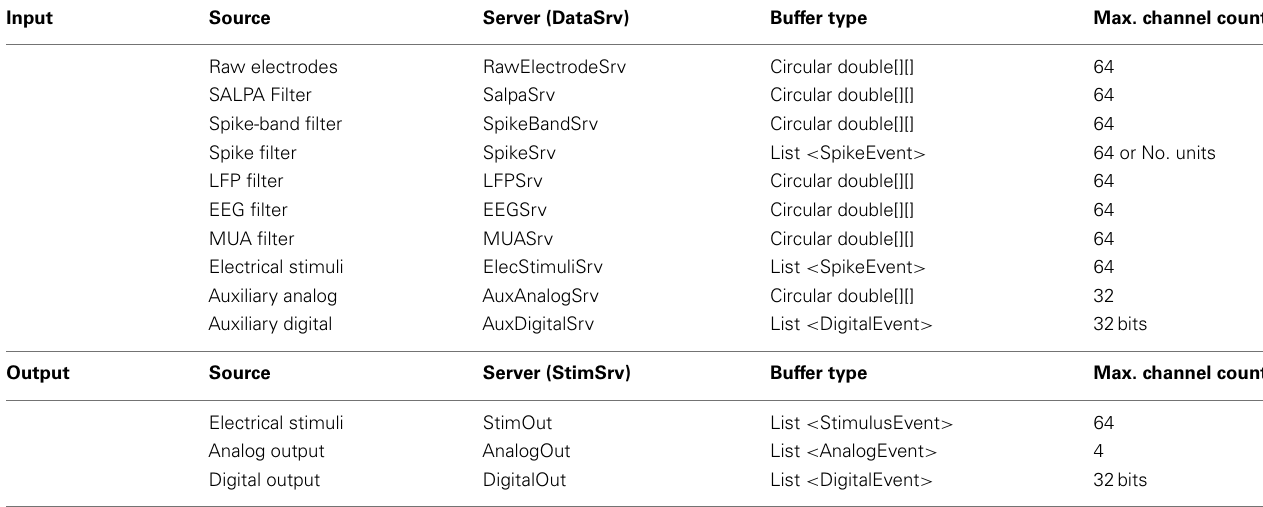
Table 1 | Overview of NeuroRighter’s input and output streams.